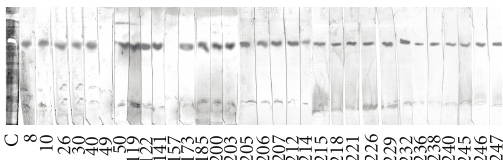
Figure 3: Immunoblot of the positive sera of the 258 human sera collected in the suburban population of Quer´etaro city (Mexico) against the SODe antigen from T. cruzi epimastigotes at a serum dilution of 1/100. Line C: SODe activity in isoelectrofocus and staining following the technique of Beyer and Fridovich [15].